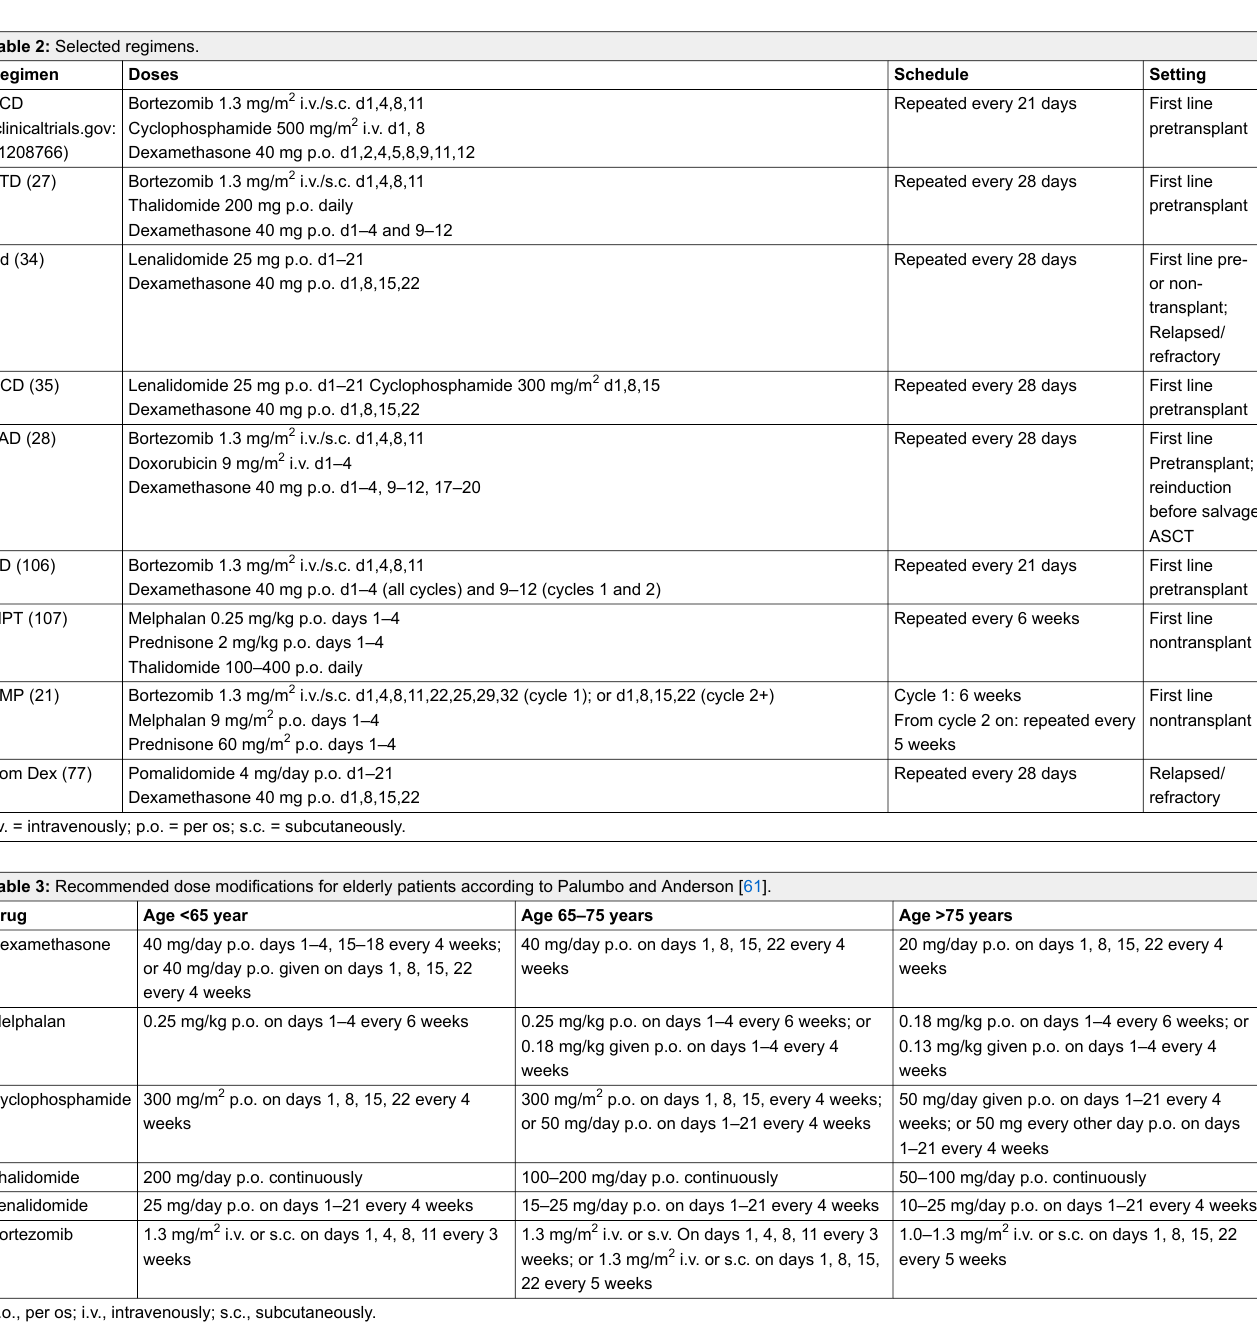
Table 2: Selected regimens. Regimen Schedule Setting